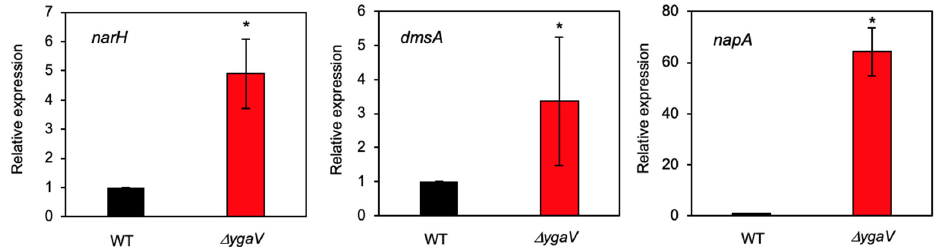
Figure 1. Relative mRNA levels of narH , dmsA and napA genes in WT and ygaV mutant ( ∆ ygaV ) as determined by quantitative real ‐ time PCR analysis. The WT levels were set to 1.0. The gyrA gene was used as an internal standard. The values are means ± SD of three biological replicates. * p < 0.05, t ‐ test.